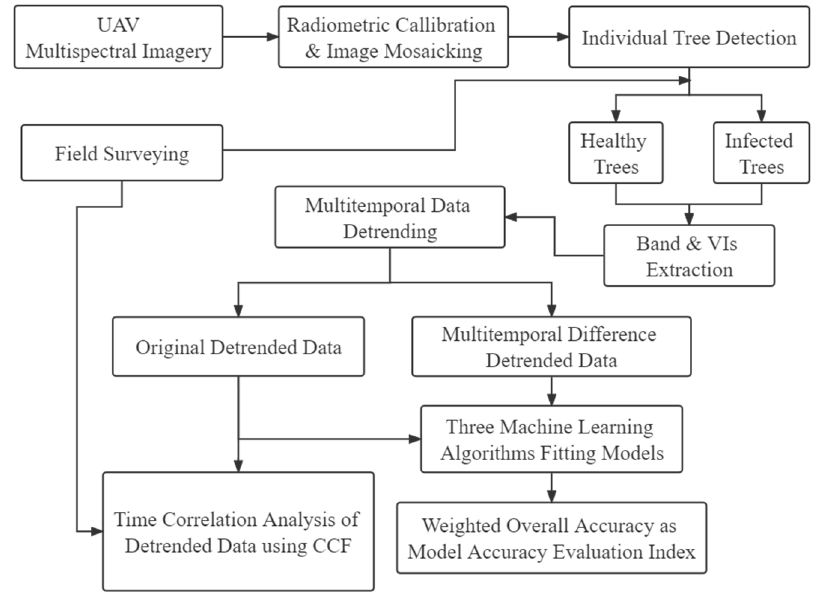
Figure 4. Flowchart of the adopted analysis